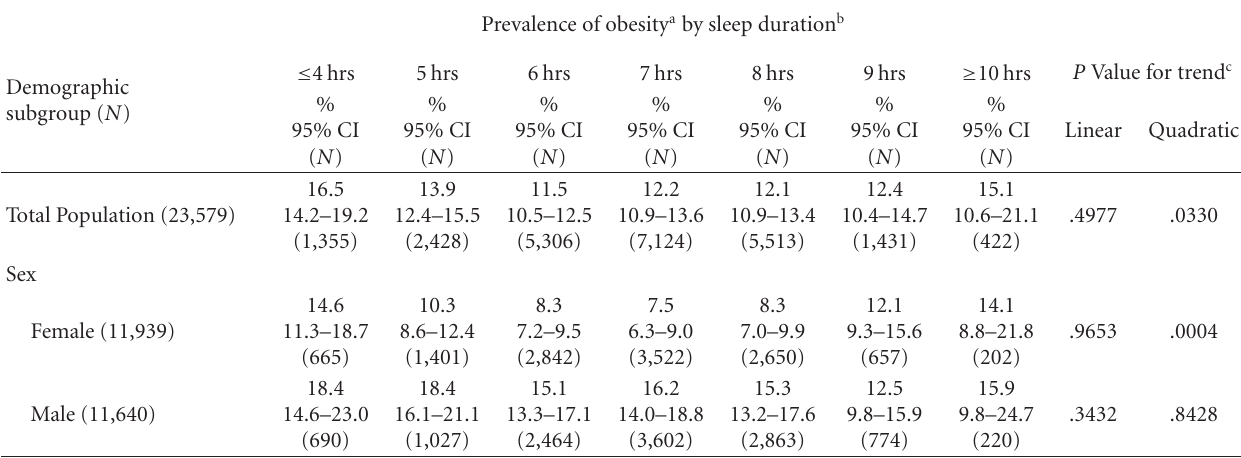
Table 3: Linear and quadratic associations between obesity and sleep duration—US high school students.